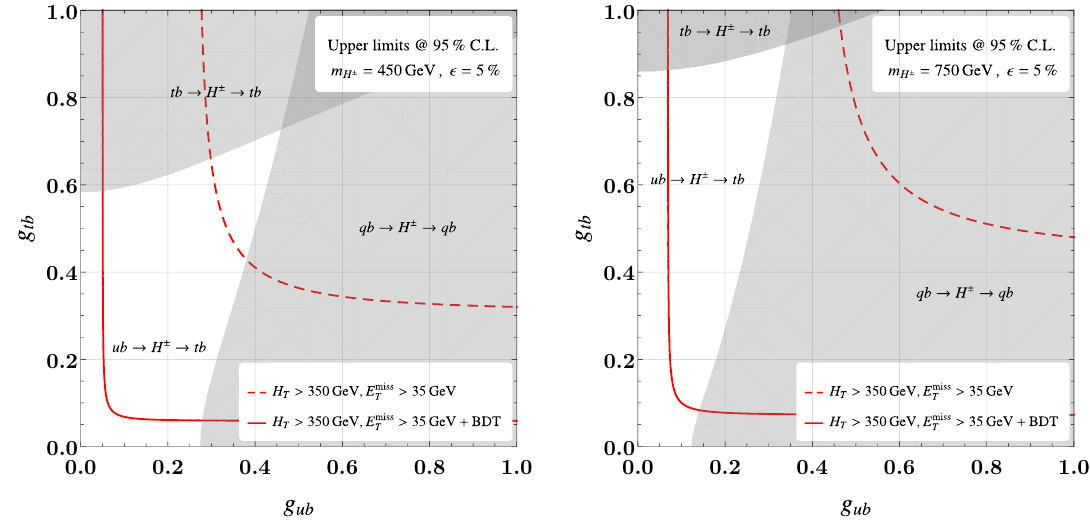
Figure 17 . As figure 16, but for the coupling g ub instead of g cb